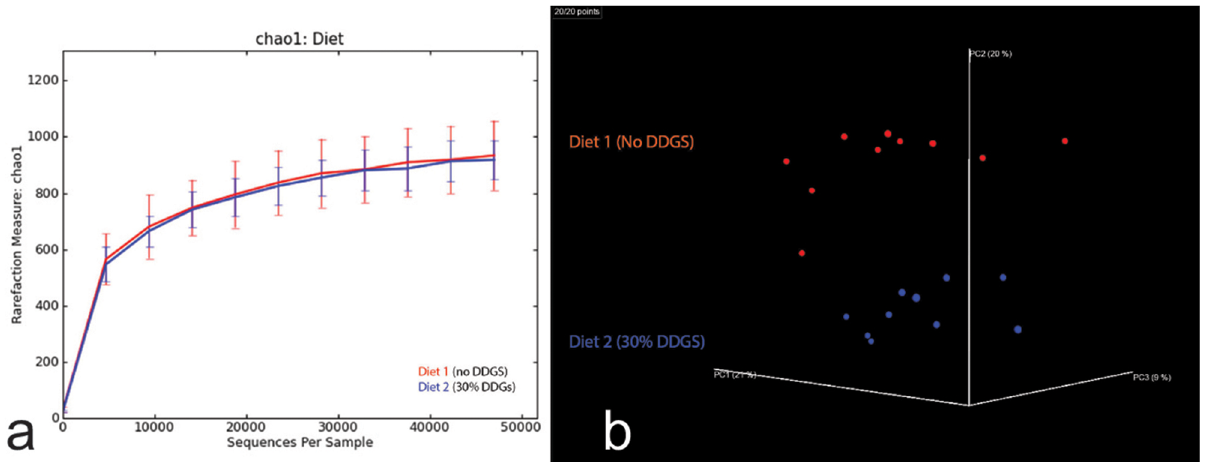
Fig 1. Feeding increased insoluble fiber to pigs alters beta but not alpha diversity in the colonic microbiota. (a) Rarefaction curves comparing alpha diversity (chao1) of colonic microbiota samples from pigs fed either Diet 1 (no DDGS) or Diet 2 (30% DDGS) and revealing no significant differences in richness ( P = .736; n = 10 samples per diet group). (b) PCoA plot demonstrating significant beta diversity (Bray-Curtis dissimilarity) between diet groups ( P < .001).